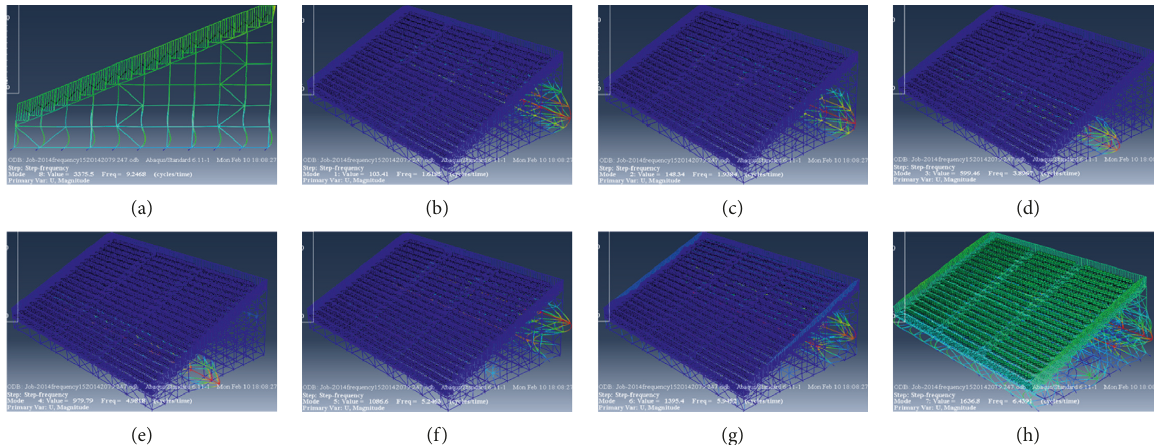
Figure 19: The structural model shape of horizontal directions. (a) X direction, (b) 1st at Z direction, (c) 2nd at Z direction, (d) 3rd at Z direction, (e) 4th at Z direction, (f) 5th at Z direction, (j) 6th at Z direction, and (h) 7th at Z direction.